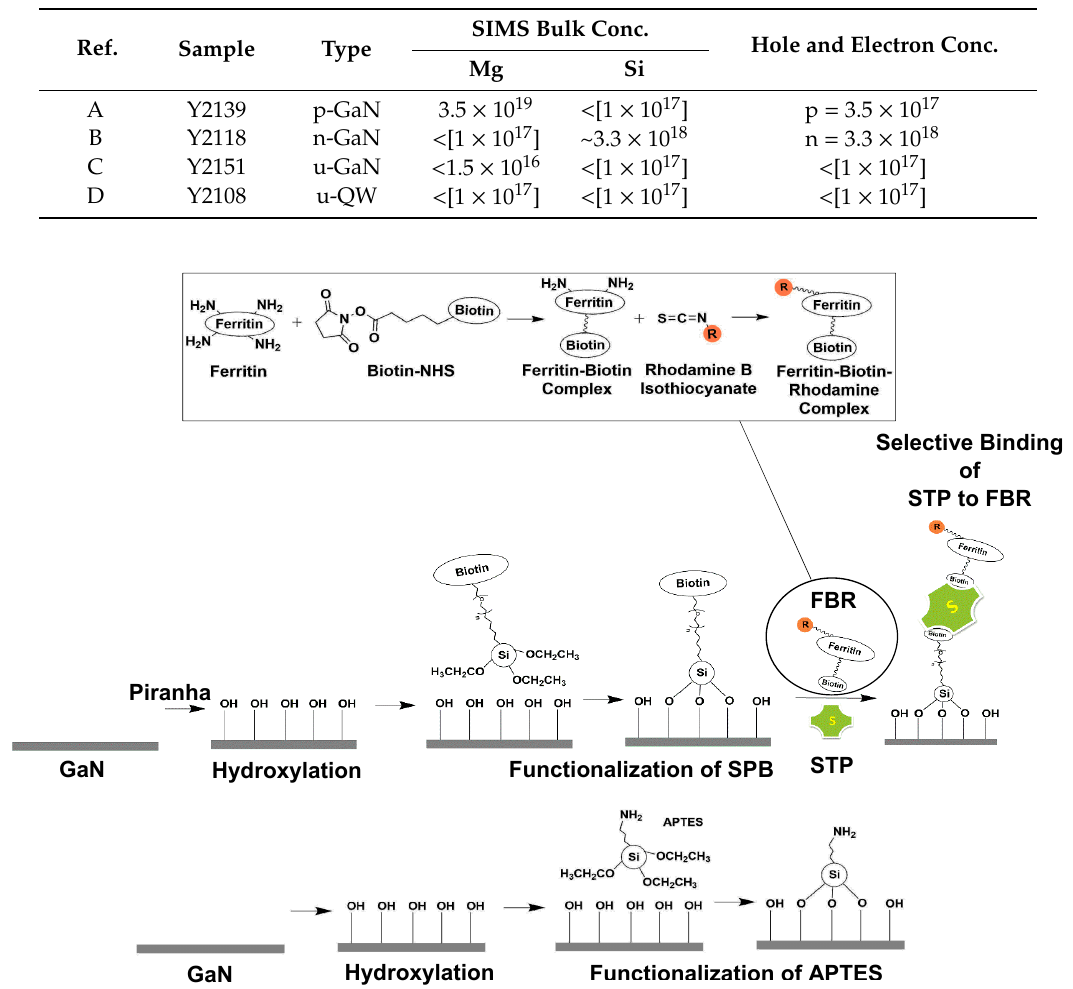
SIMS Bulk Conc. Hole and Mg